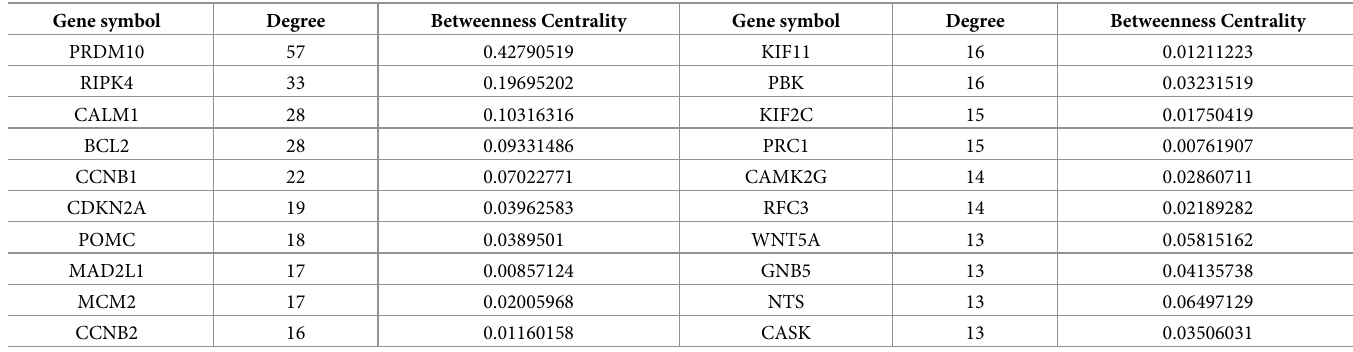
Table 2. Top 20 hub genes which were screened with degrees more than